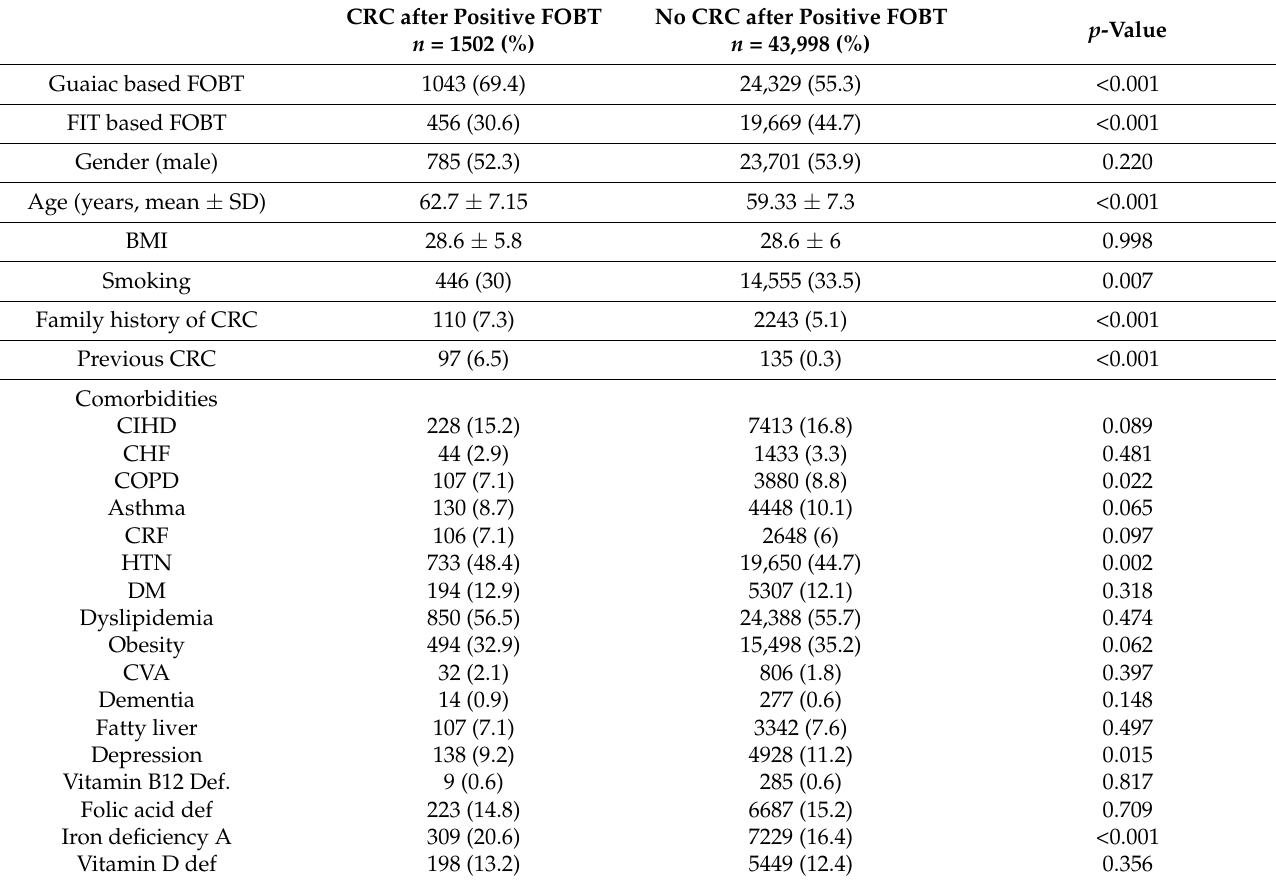
Table 1. Demographics and comorbidities in the study